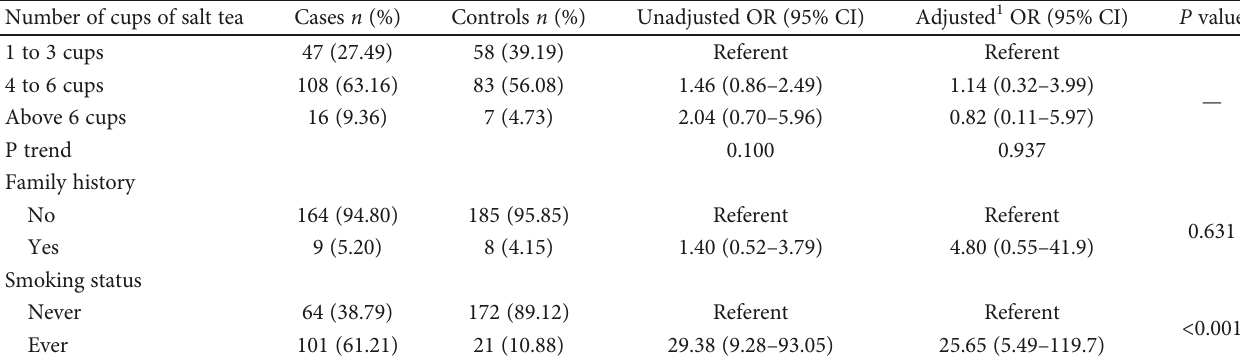
Table 2: Association of various dietary and environmental factors with gastric cancer in Kashmir.